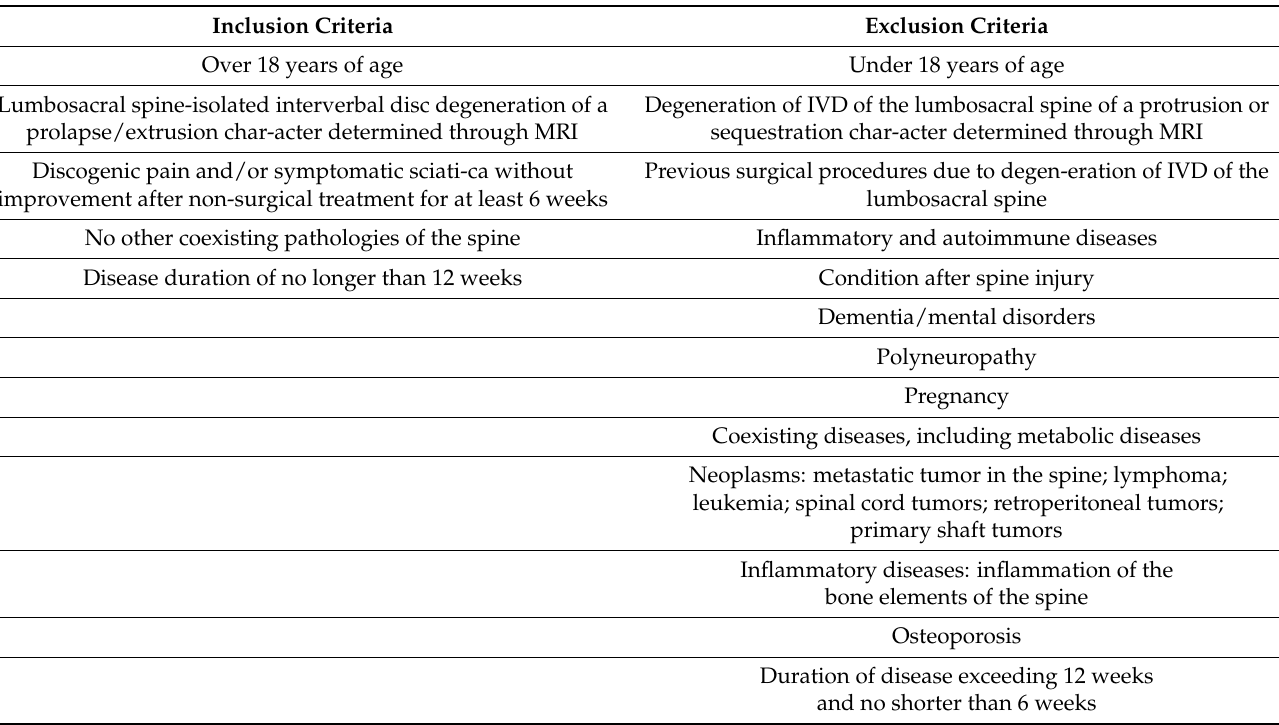
Table 1. Inclusion and exclusion criteria for the study